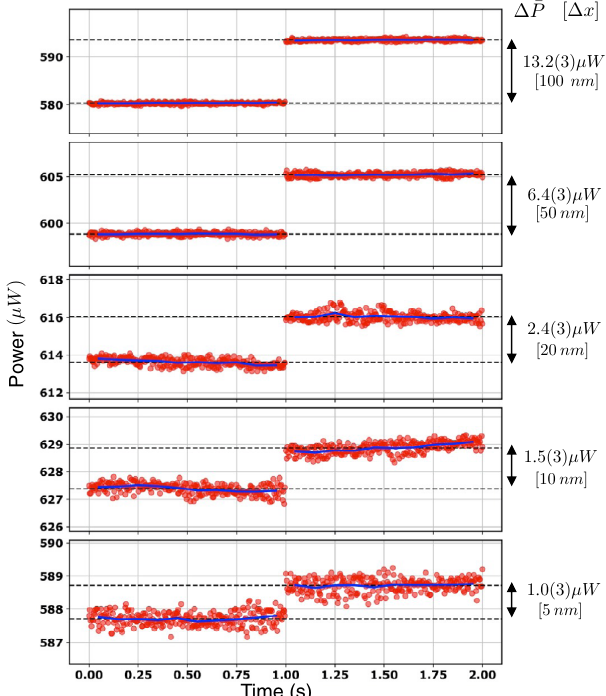
Fig. 3 Step measurements for gear Λ = 50 μ m. Each plot reports the optical power measured for 1 s (250 red points) before and after a controlled step Δ x of the translation stage. Blue lines represent the average power calculated over time intervals of 0.1 s while black dashed lines mark the total average power calculated before and after each step. The corresponding power difference Δ (cid:1) P is reported, together with the step amplitude (in square brackets), on the right side of each